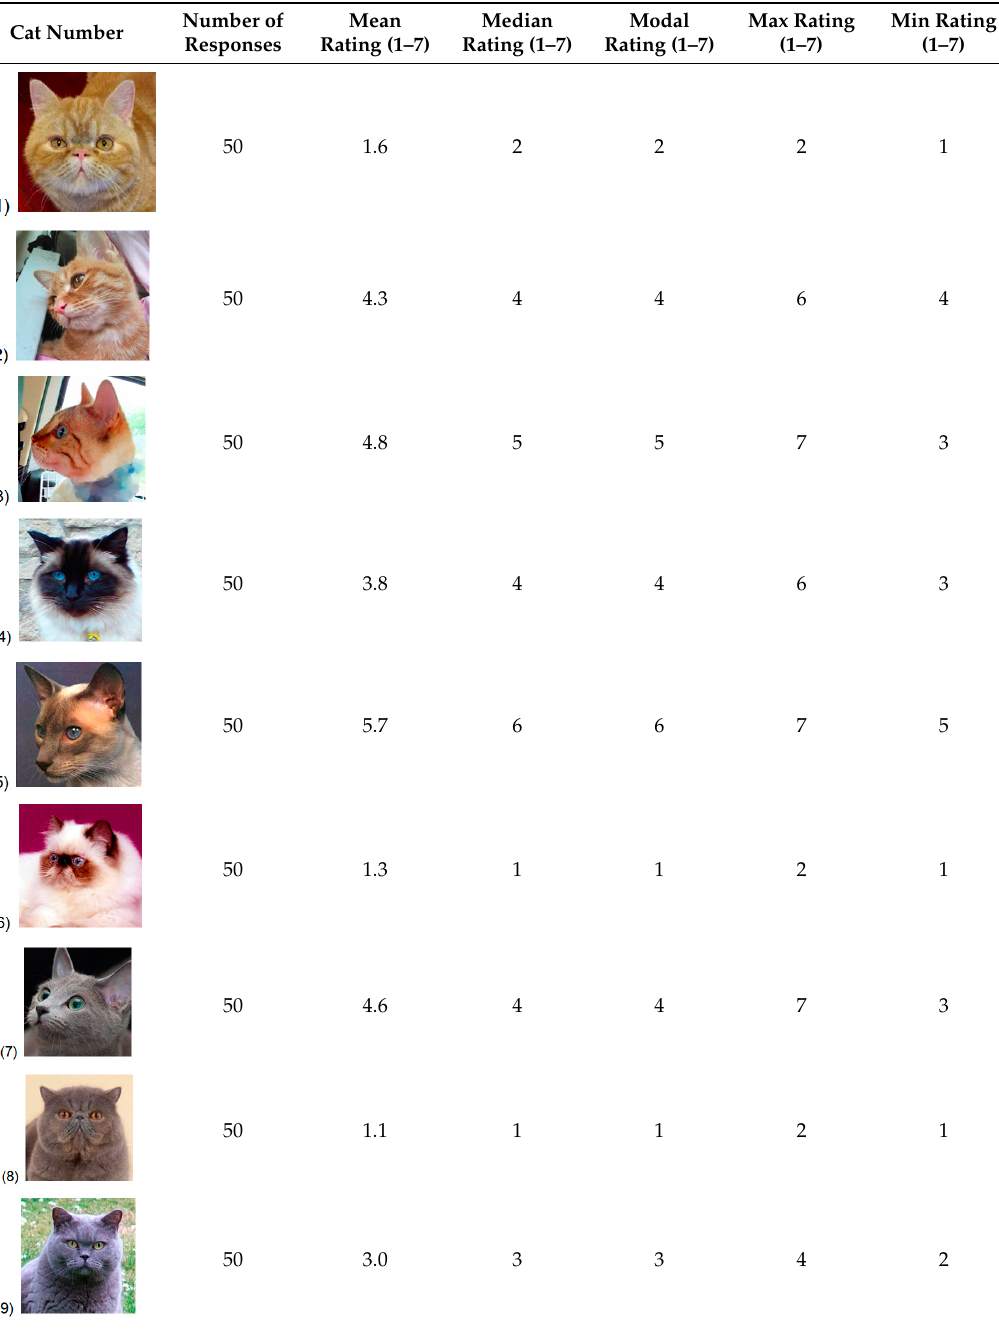
dataset that may influence the median scores reported in Table 2, a generalized estimating equation Table 1. Cephalic rating provided for 15 cat images by veterinarian members of the International Table 1. Cephalic rating provided for 15 cat images by veterinarian members of the International Table 1. Cephalic rating provided for 15 cat images by veterinarian members of the International Table 1. Cephalic rating provided for 15 cat images by veterinarian members of the International Table 1. Cephalic rating provided for 15 cat images by veterinarian members of the International Table 1. Cephalic rating provided for 15 cat images by veterinarian members of the International Society for Feline Medicine list serve ( n = 45–50). Ratings were based on the following numerical scale: Society for Feline Medicine list serve ( n = 45–50). Ratings were based on the following numerical scale: Table 1. Cephalic rating provided for 15 cat images by veterinarian members of the International Society for Feline Medicine list serve ( n = 45–50). Ratings were based on the following numerical scale: Table 1. Cephalic rating provided for 15 cat images by veterinarian members of the International Table 1. Cephalic rating provided for 15 cat images by veterinarian members of the International Table 1. Cephalic rating provided for 15 cat images by veterinarian members of the International Society for Feline Medicine list serve ( n = 45–50). Ratings were based on the following numerical scale: Society for Feline Medicine list serve ( n = 45–50). Ratings were based on the following numerical scale: Society for Feline Medicine list serve ( n = 45–50). Ratings were based on the following numerical scale: 1 = extreme brachycephaly (BC) (having the shortest muzzle possible); 2 = moderate BC; 3 = mild BC; 1 = extreme brachycephaly (BC) (having the shortest muzzle possible); 2 = moderate BC; 3 = mild BC; Society for Feline Medicine list serve ( n = 45–50). Ratings were based on the following numerical scale: 1 = extreme brachycephaly (BC) (having the shortest muzzle possible); 2 = moderate BC; 3 = mild BC; Society for Feline Medicine list serve ( n = 45–50). Ratings were based on the following numerical scale: Society for Feline Medicine list serve ( n = 45–50). Ratings were based on the following numerical scale: 1 = extreme brachycephaly (BC) (having the shortest muzzle possible); 2 = moderate BC; 3 = mild BC; Society for Feline Medicine list serve ( n = 45–50). Ratings were based on the following numerical scale: 1 = extreme brachycephaly (BC) (having the shortest muzzle possible); 2 = moderate BC; 3 = mild BC; 1 = extreme brachycephaly (BC) (having the shortest muzzle possible); 2 = moderate BC; 3 = mild BC; 4 = mesocephalic; 5 = mild dolichocephaly (DC); 6 = moderate DC; 7 = extreme DC (having the longest 4 = mesocephalic; 5 = mild dolichocephaly (DC); 6 = moderate DC; 7 = extreme DC (having the longest 1 = extreme brachycephaly (BC) (having the shortest muzzle possible); 2 = moderate BC; 3 = mild BC; 4 = mesocephalic; 5 = mild dolichocephaly (DC); 6 = moderate DC; 7 = extreme DC (having the longest 1 = extreme brachycephaly (BC) (having the shortest muzzle possible); 2 = moderate BC; 3 = mild BC; 1 = extreme brachycephaly (BC) (having the shortest muzzle possible); 2 = moderate BC; 3 = mild BC; 4 = mesocephalic; 5 = mild dolichocephaly (DC); 6 = moderate DC; 7 = extreme DC (having the longest 1 = extreme brachycephaly (BC) (having the shortest muzzle possible); 2 = moderate BC; 3 = mild BC; 4 = mesocephalic; 5 = mild dolichocephaly (DC); 6 = moderate DC; 7 = extreme DC (having the longest muzzle muzzle possible). 4 = mesocephalic; 5 = mild dolichocephaly (DC); 6 = moderate DC; 7 = extreme DC (having the longest muzzle possible). 4 = mesocephalic; 5 = mild dolichocephaly (DC); 6 = moderate DC; 7 = extreme DC (having the longest 4 = mesocephalic; 5 = mild dolichocephaly (DC); 6 = moderate DC; 7 = extreme DC (having the longest muzzle possible). muzzle possible). 4 = mesocephalic; 5 = mild dolichocephaly (DC); 6 = moderate DC; 7 = extreme DC (having the longest muzzle possible). muzzle possible). muzzle possible). muzzle possible). muzzle possible).